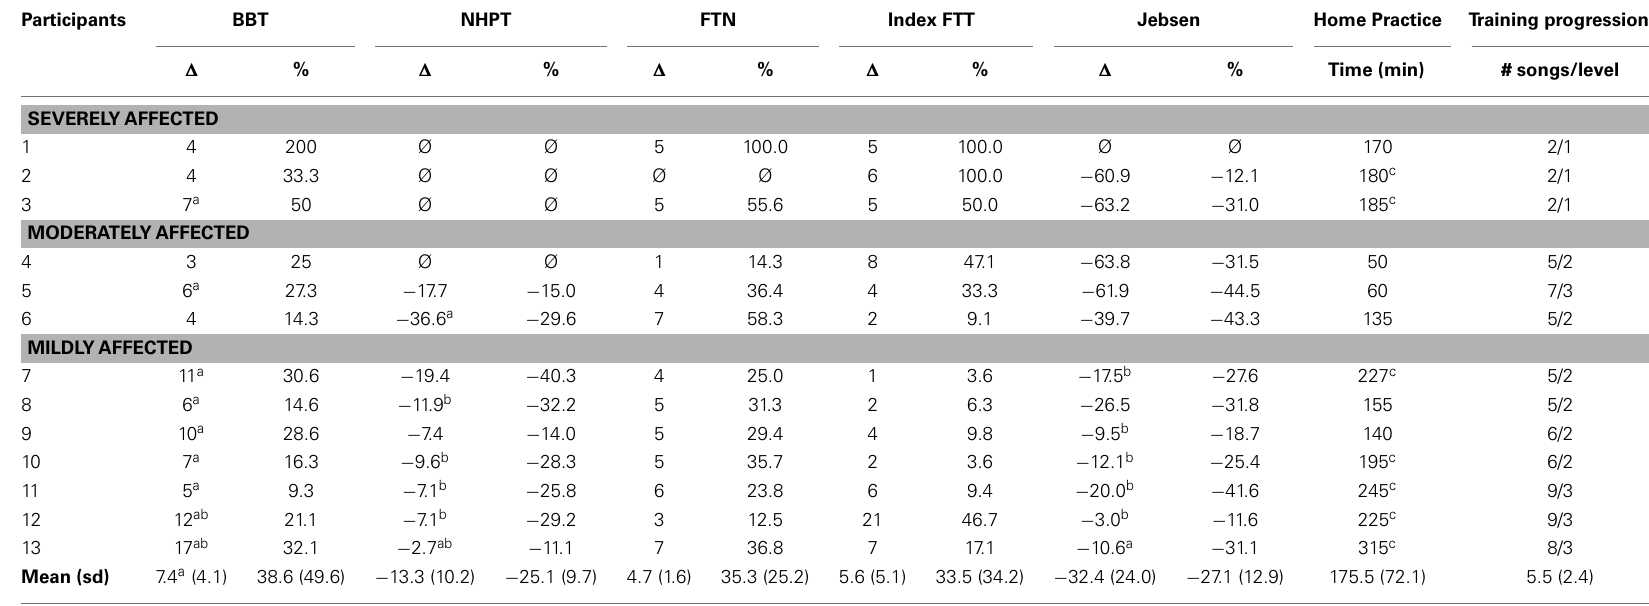
Table 3 | Changes on motor function tests post- vs. pre-intervention